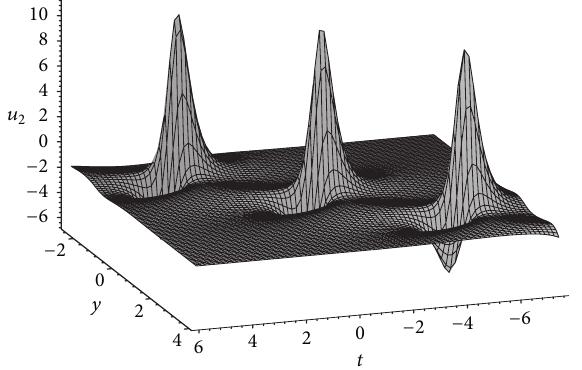
Figure 2: The figure of 𝑢 2 (𝑡,𝑥, 𝑦,𝑧) as 𝑢 0 = −2 , 𝑏 = 3 , 𝜔 = 3.5 , 𝑝 = 0.6092400758 , 𝑥 = −1 , and 𝑧 = −2